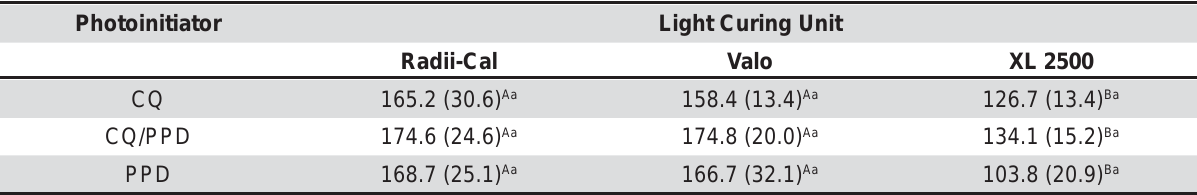
Table 2- Mean FS value (MPa) and standard error (±) provided for each of the photoinitiator systems Photoinitiator